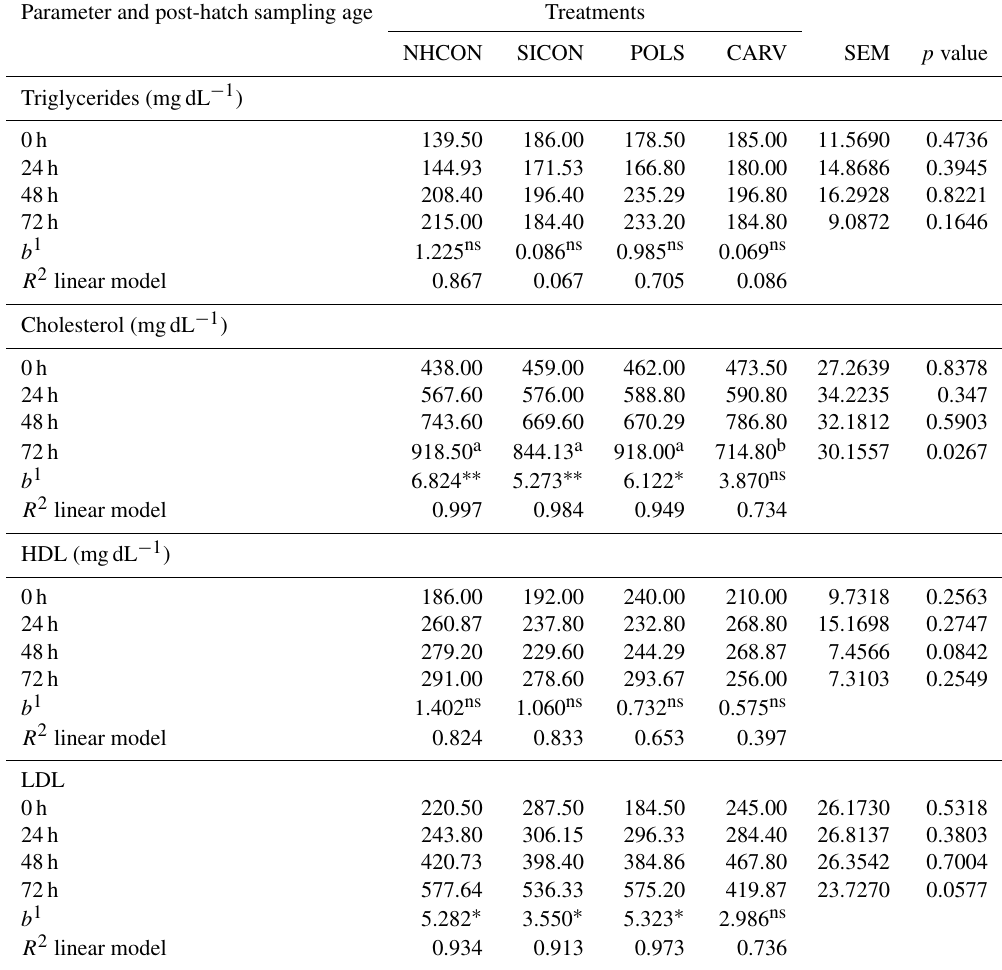
Table 4. Blood lipid constituent concentrations in chicks subjected to experimental treatments, namely non-handled control (NHCON), sham injection control (SICON), polysorbate-80 injection (POLS), and carvacrol injection (CARV), in post-hatch sampling